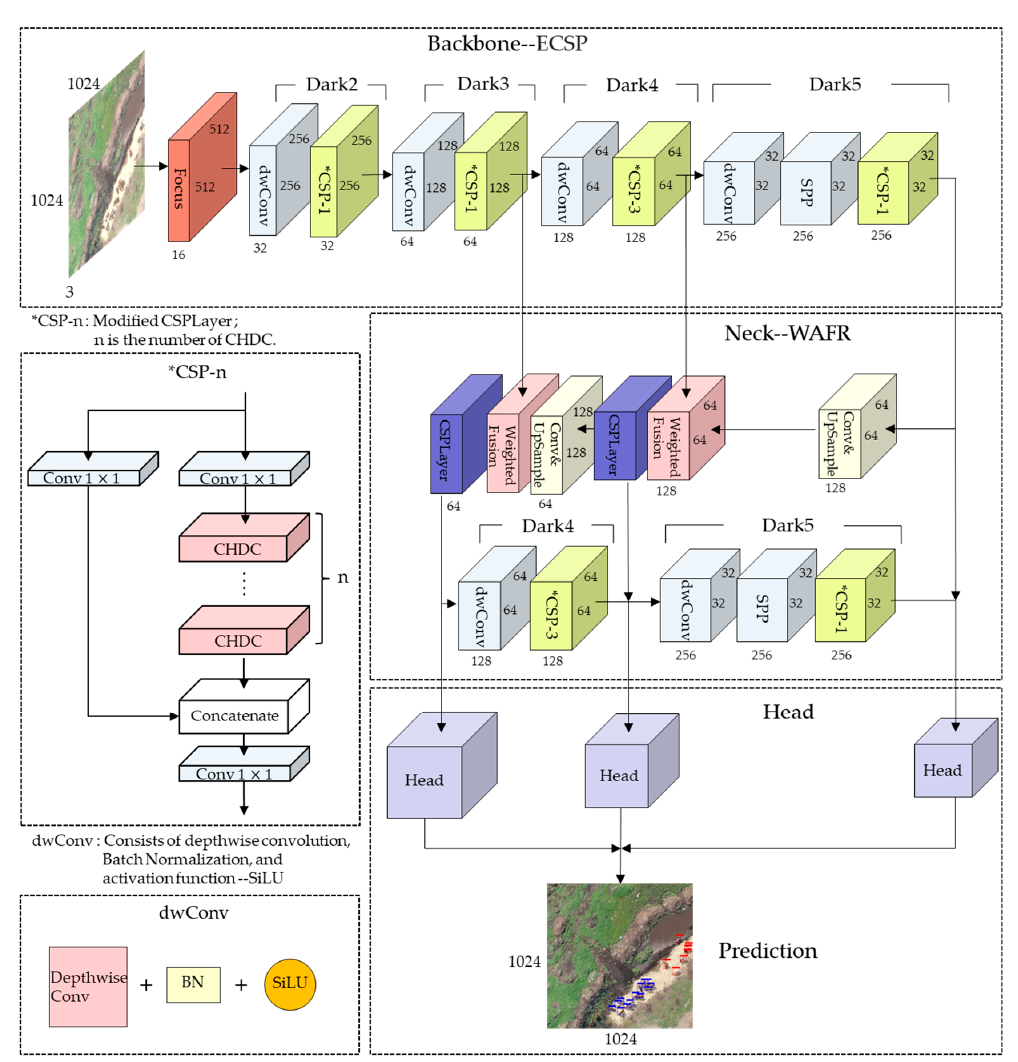
Figure 7. Network structure of the GLDM, roughly divided into parts of backbone, neck, and head. The backbone part is the proposed ECSP, and the neck part is the proposed WAFR. The backbone part is the proposed ECSP, and the neck part is the proposed